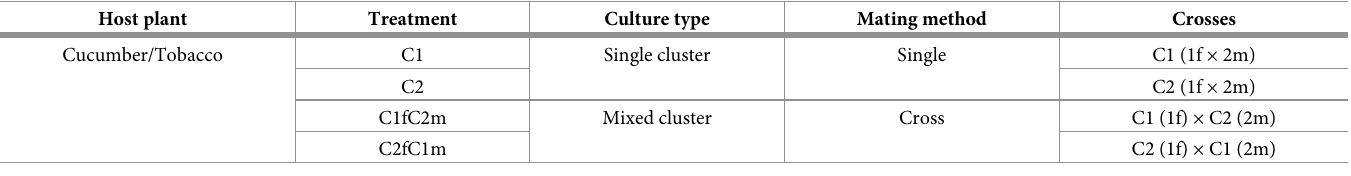
Table 1. Single and cross mating groups between cluster 1 (C1) and cluster 2 (C2) of B . tabaci MED. Host plant Treatment Culture type Mating method Crosses